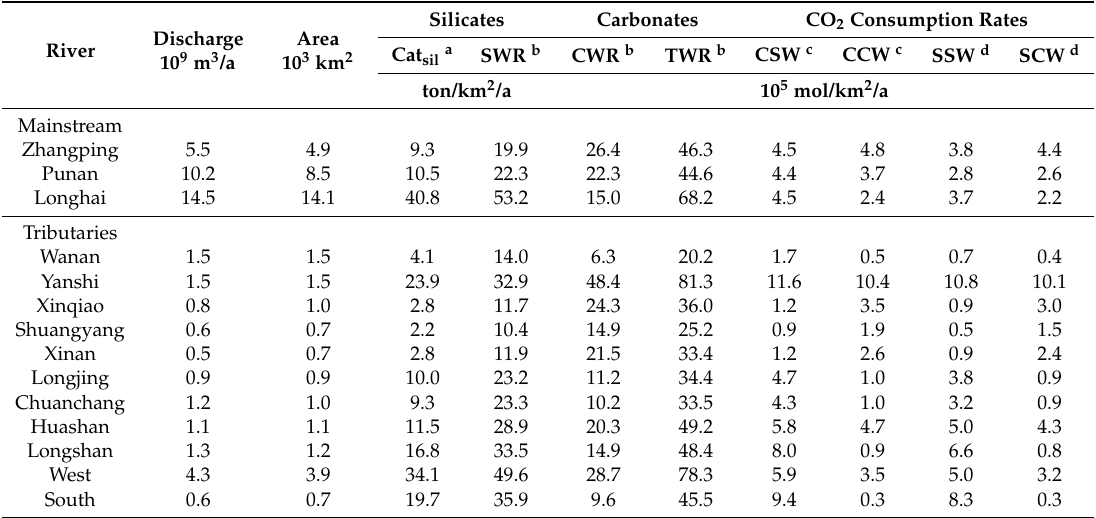
Table 2. Chemical weathering rates and associated CO 2 consumption in the